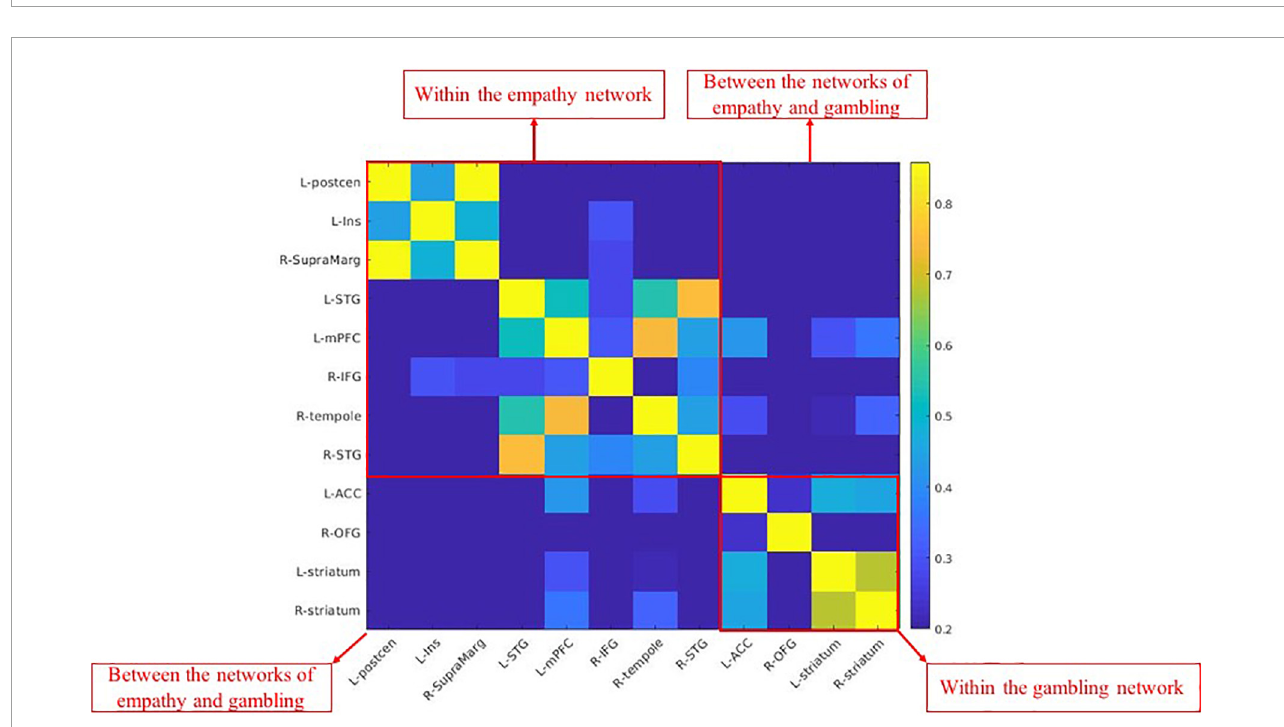
FIGURE1 The brain regions identified for empathy and gambling networks. (A) The brain regions of the empathy network; (B) the brain regions of the gambling network.